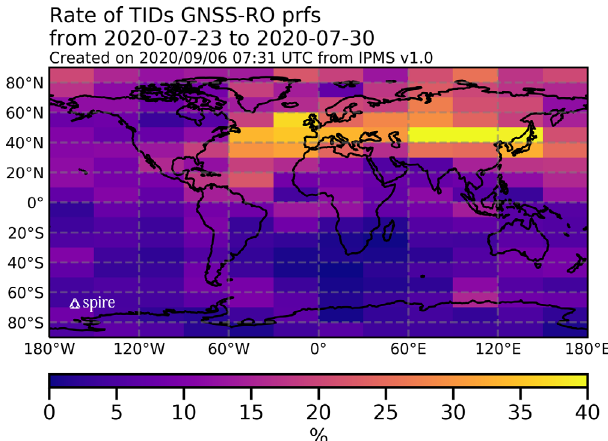
Fig. 14. Relative density of TIDs from Spire pro fi les to total number of pro fi les gathered globally from 2020/07/23 to 2020/07/30. The TIDs are picked up at high rates (i.e., more than 50%) at mid-latitude in the northern hemisphere (summertime), especially in the Chinese and Japanese sectors, consistent with TID climatological